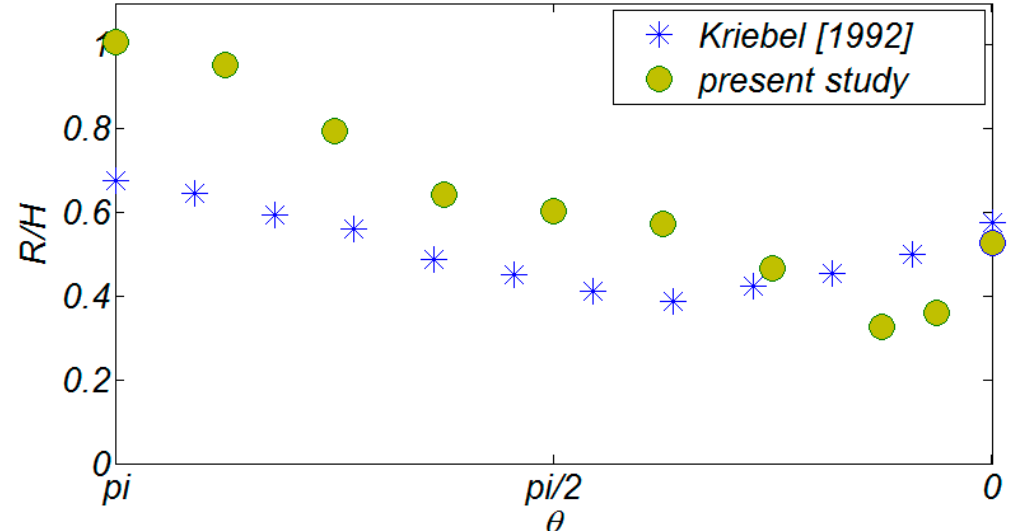
Figure 16. Location of gauges NO 1 through NO 10.